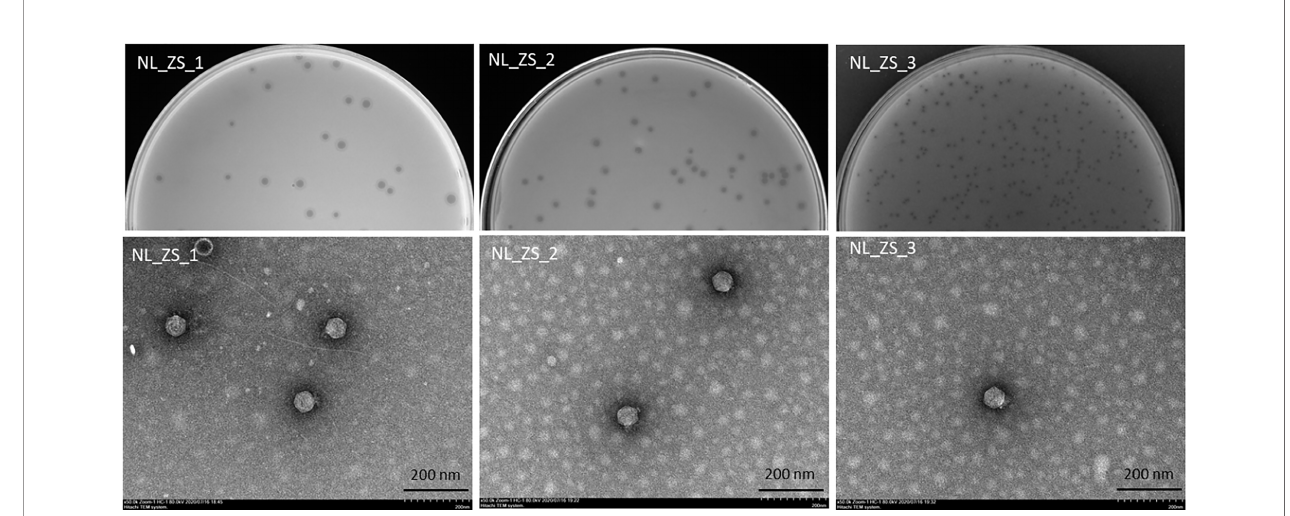
FIGURE 3 | Plaque images (up) and their corresponding TEM micrographs (below). Phages were stained with 2% sodium phosphotungstate and were found to have short small podophage morphology. Scale bar, 200 nm.